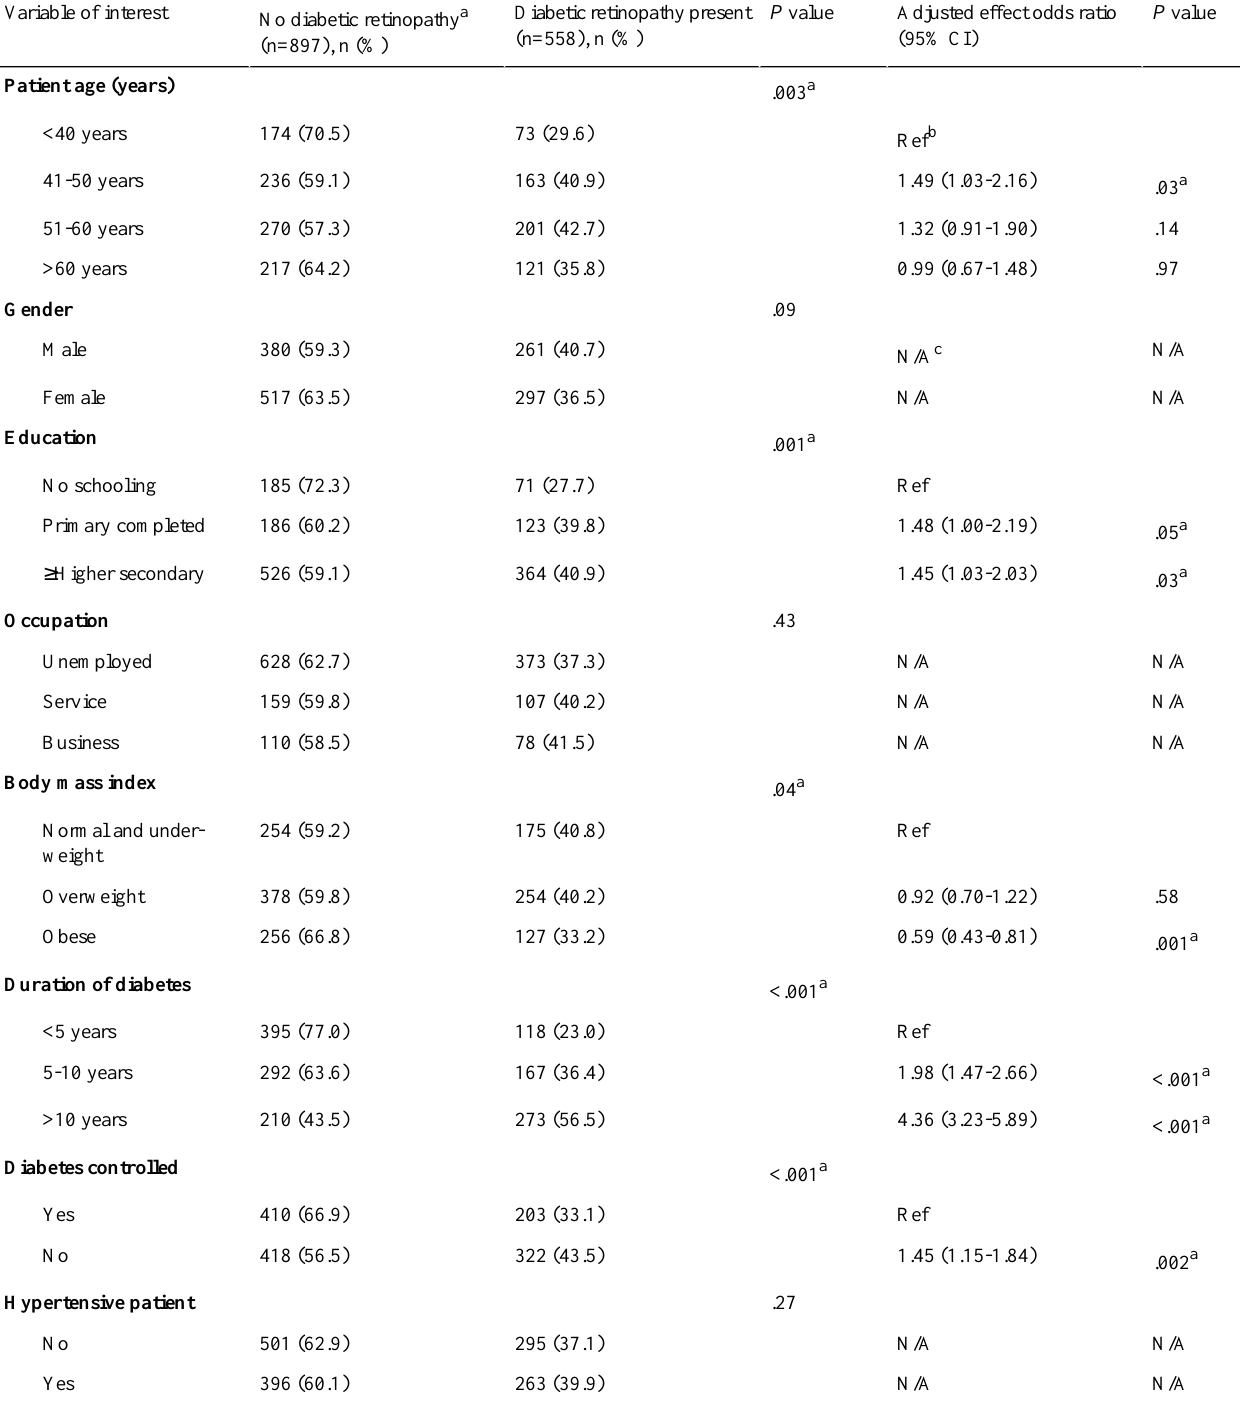
Table 4. Factors associated with diabetic retinopathy occurrence in Bangladesh from July 2017 to June